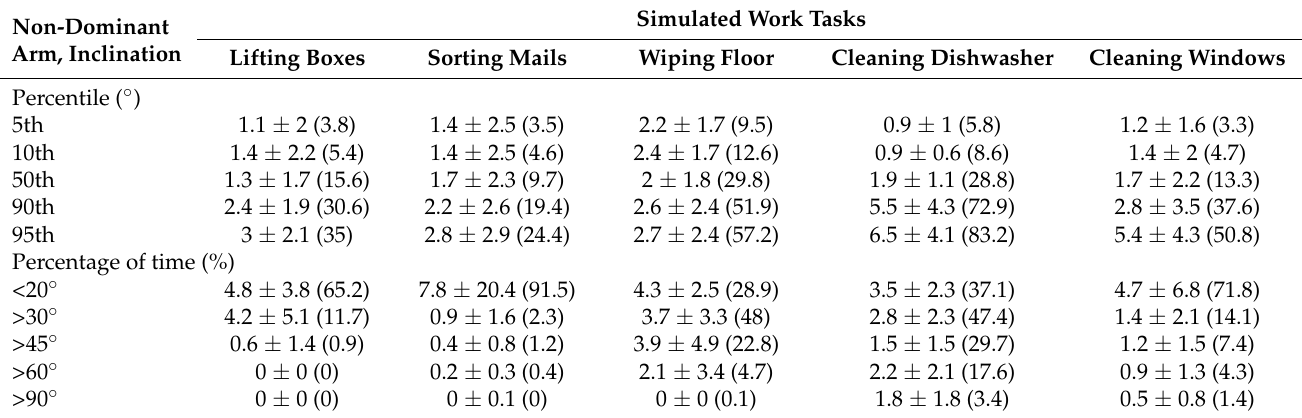
Table A1. The mean ± standard deviation of the mean absolute errors (MAEs) of the non-dominant arm inclination angle between cloth sensors and skin sensors during the five simulated tasks, with the reference value of skin sensors shown in brackets ( n = 12).